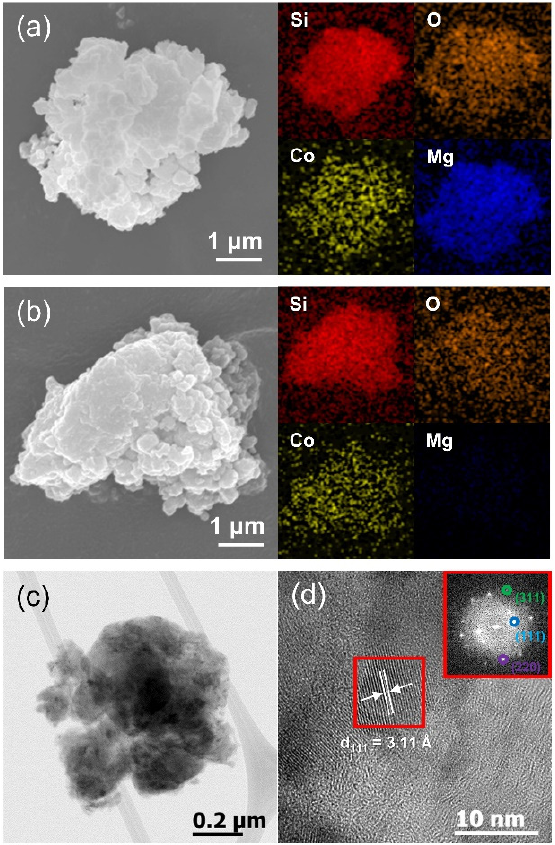
Figure 3. SEM images with EDS elemental mapping results for each element: ( a ) before and ( b ) after the etching process; ( c ) TEM image and ( d ) HR-TEM image (inset: FFT pattern).